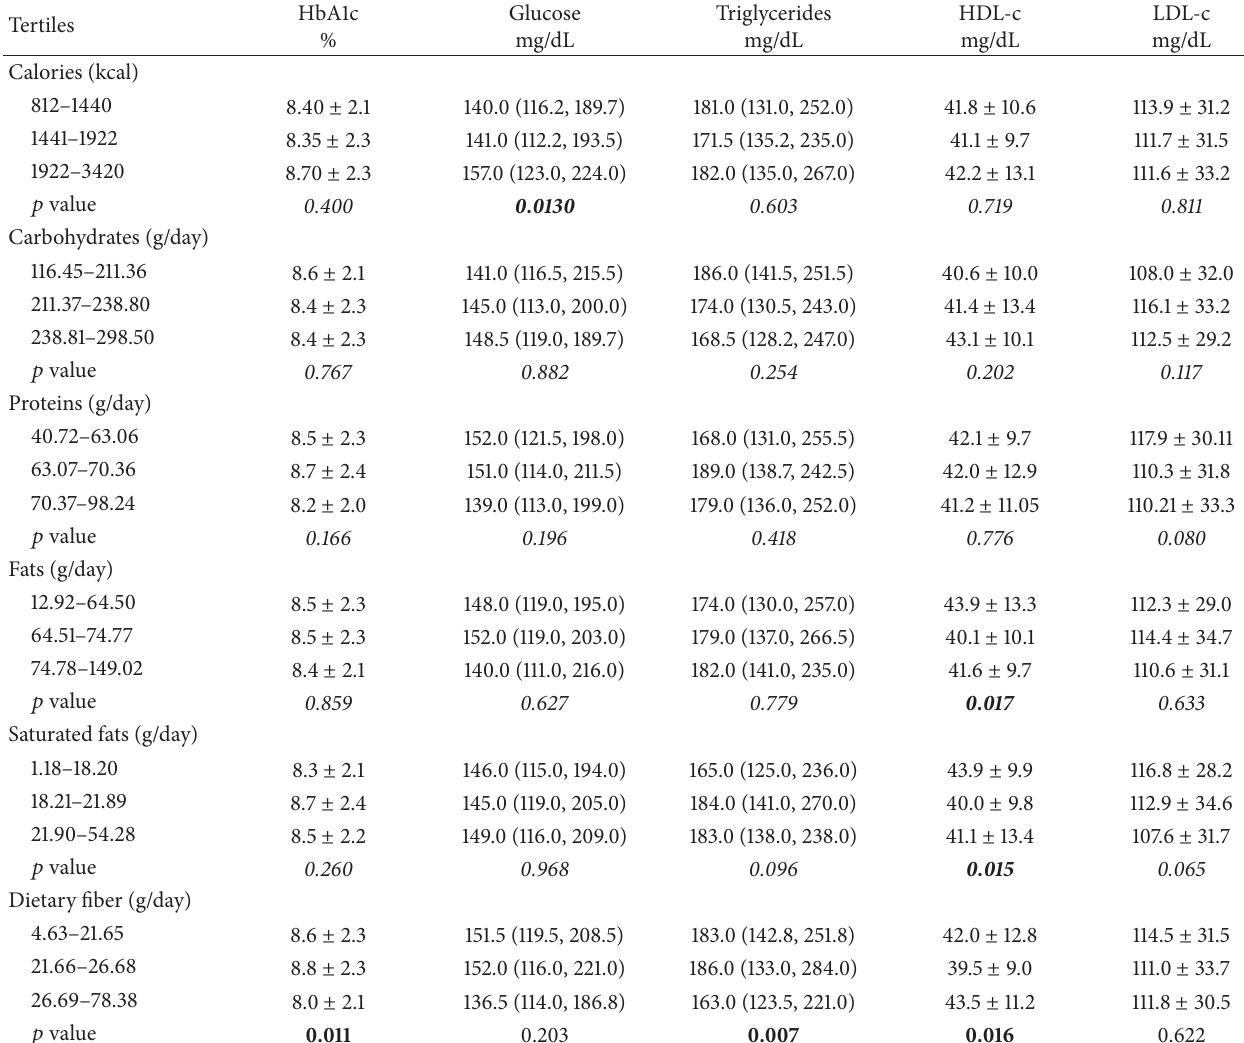
Table 3: Association of diet components and metabolic control variables ( 𝑛 = 395